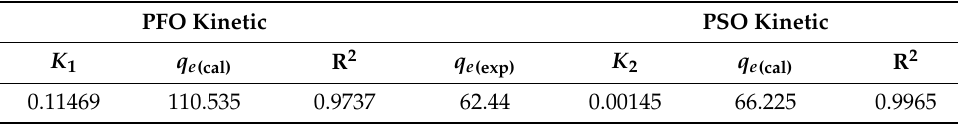
Figure 10. ( A ) PFO and ( B ) PSO kinetics of W(VI) ions absorbed on HNAP/QA. Table 2. Kinetic parameters of W(VI) ions adsorbed on